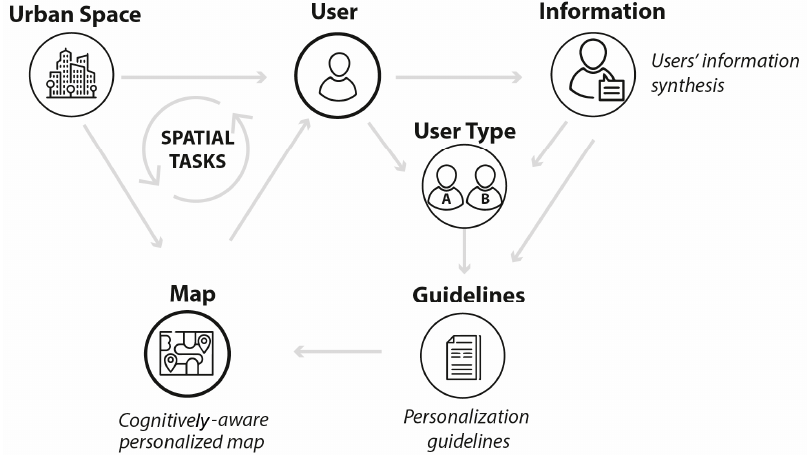
Figure 2. The conceptual framework to developing cognitively aware personalized maps.